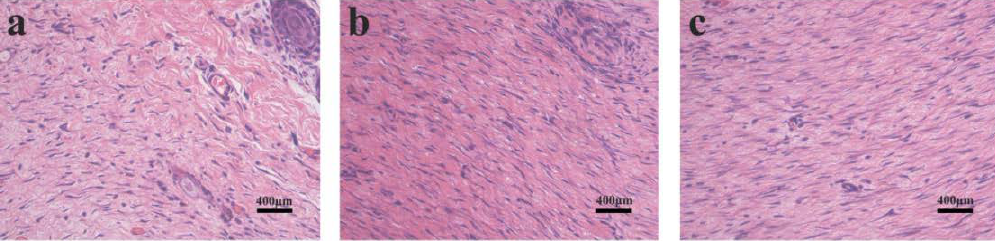
Figure 9. H and E staining images of the wound tissue on day 16. ( a ) Control; ( b ) PLA-treated; and ( c ) PLA/PVA/SA-treated.